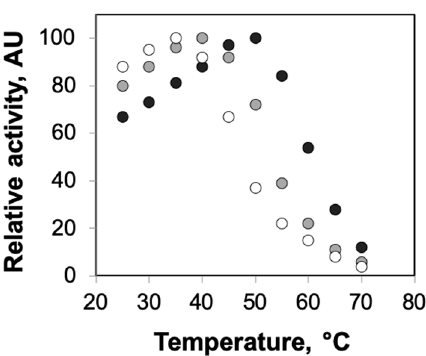
Figure 2. Optimum temperatures of HRP encapsulated in agarose gels. The enzyme activities of solution-phase HRP (white circles) and HRP encapsulated in 0.5% agarose (gray circles) and 2% agarose (black circles) were measured at different temperatures ranging from 25 to 70 °C. Each data point represents an average of triplicate measurements, with standard deviation <15%.